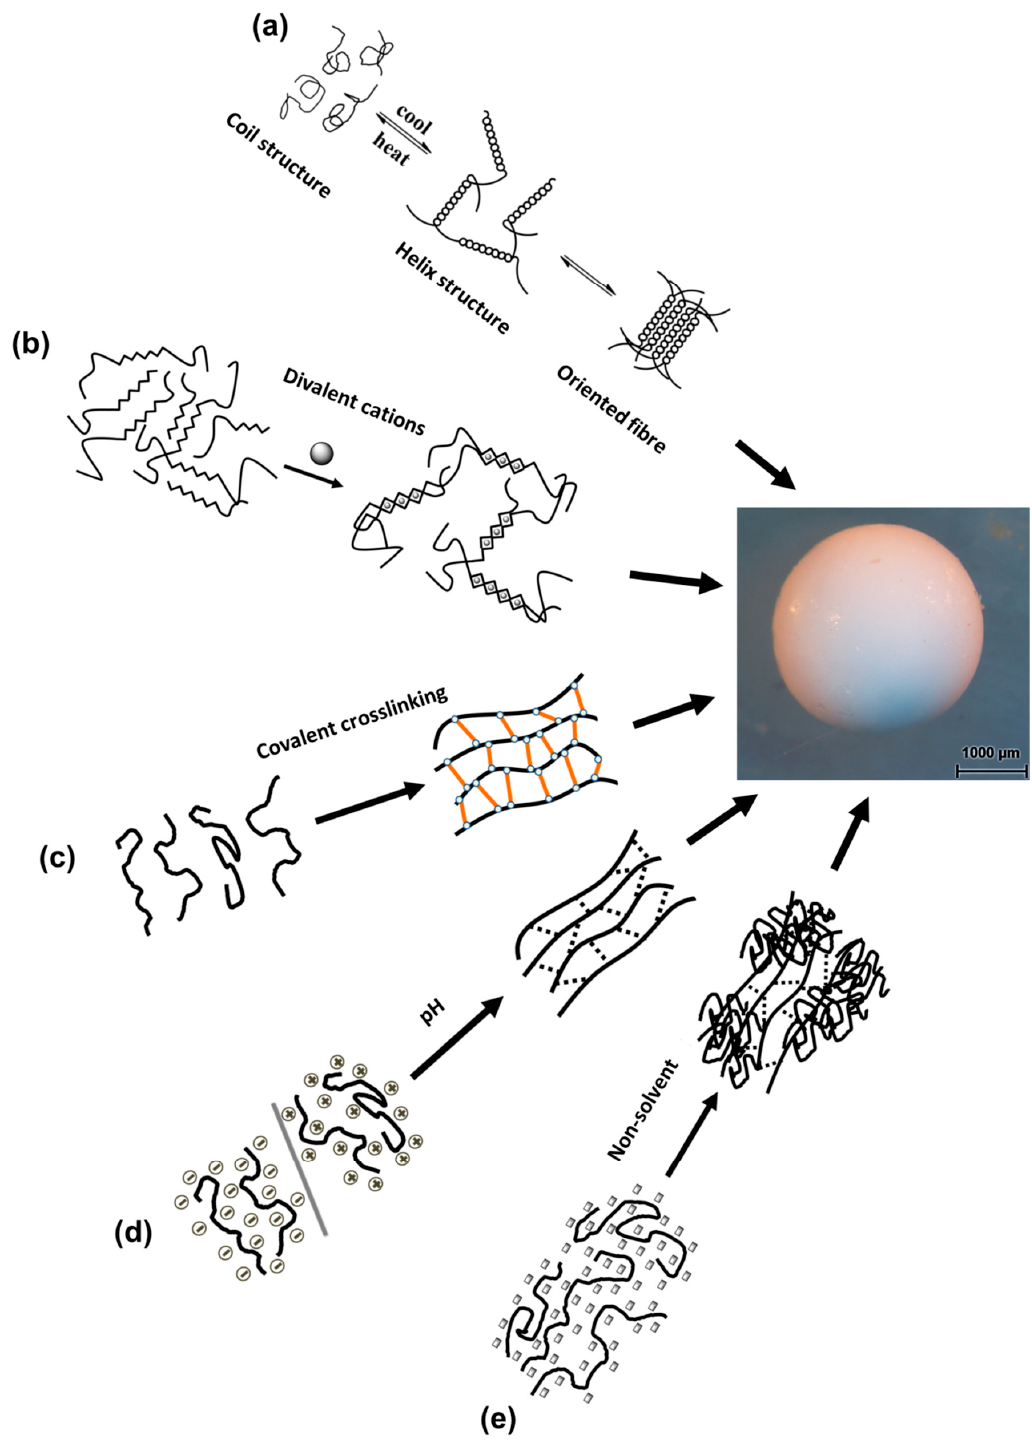
Figure 7. Illustration of the main mechanisms of formation of polysaccharide gel particles: ( a ) temperature-induced (thermotropic) gelation in which the polysaccharides undergo structural transition from coil to helix and then to double helix, ( b ) ions-induced (ionotropic) gelation in which the polysaccharide molecules are crosslinked by ions, ( c ) covalent crosslinking approach in which the polysaccharide chains are covalently crosslinked to form gel network, ( d ) pH-induced gelation and ( e ) non-solvent approach to produce a non-solvent filled gel network.